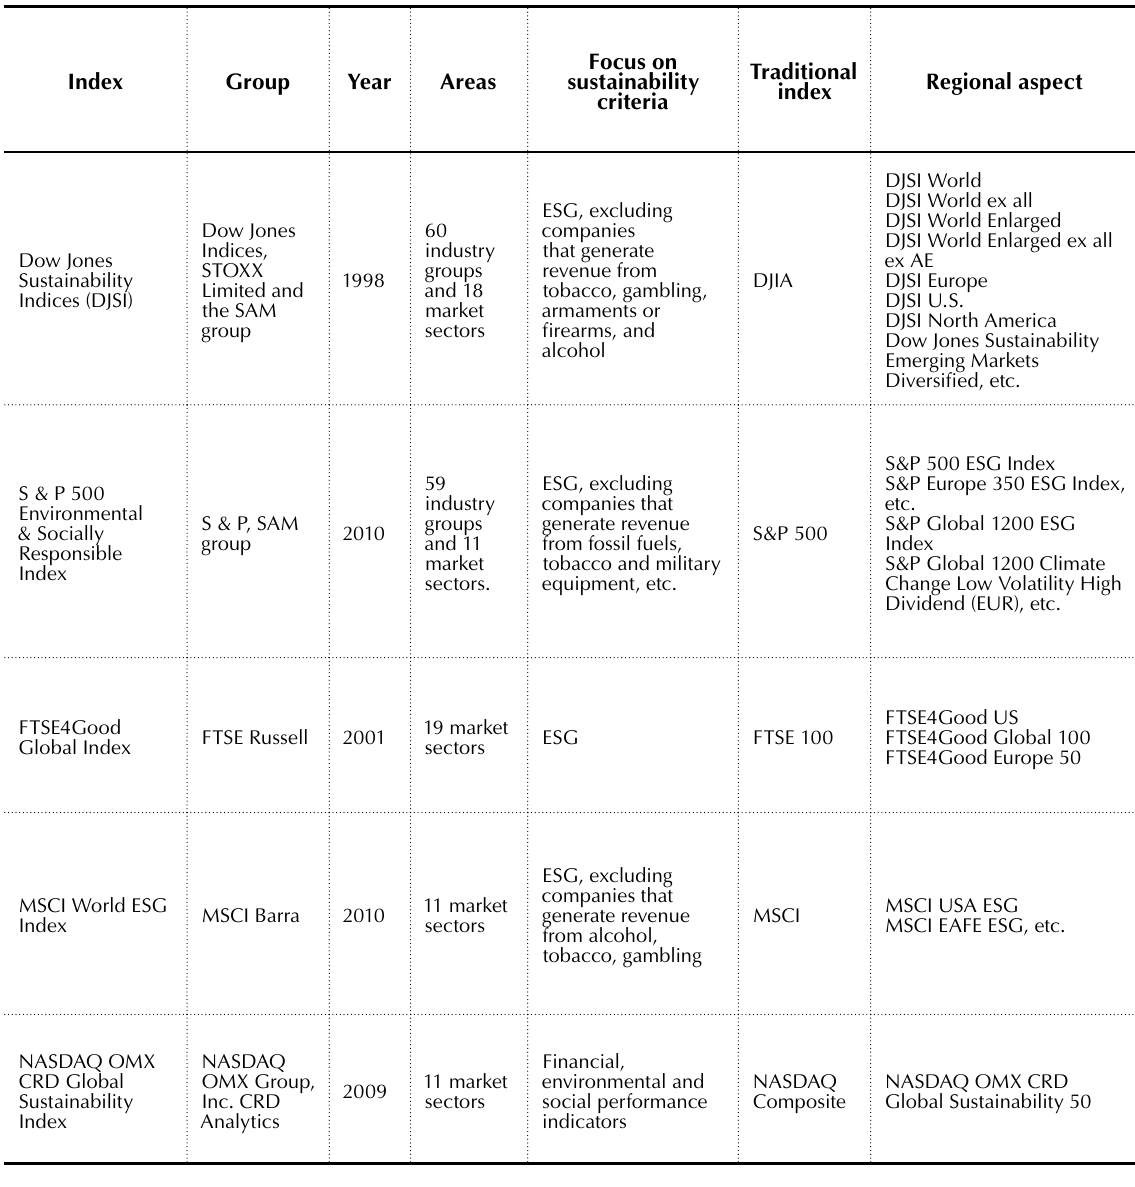
Table 1. Indices of sustainable development and the corresponding financial indices studied by the